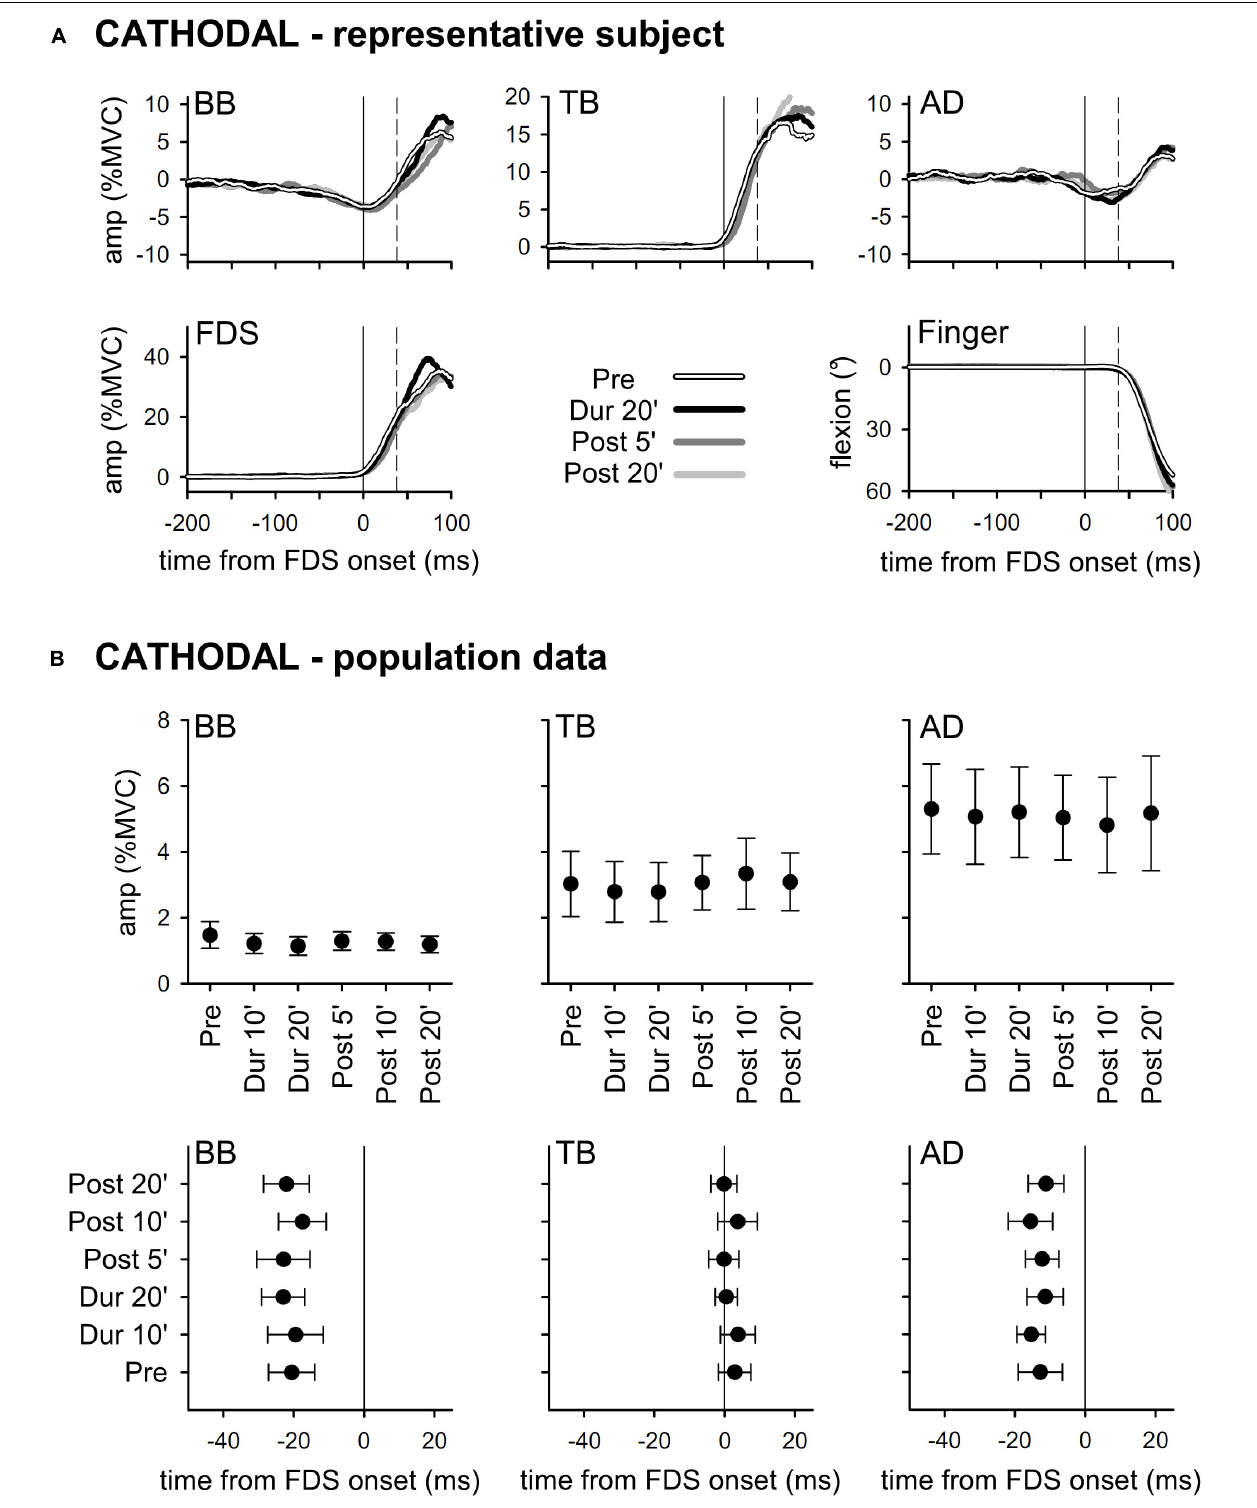
FIGURE 4 | Traces from a representative subject (A) , as well as mean ( ± SE) amplitude and latencies of APAs recorded in the BB, TB, and AD muscles of all subjects (B) who underwent CATHODAL tDCS. Same layout as in Figure 2 . Also with this polarity, tDCS had no effect on APAs (no significant changes Pre vs. Dur 10’ vs. ...vs. Post 20’